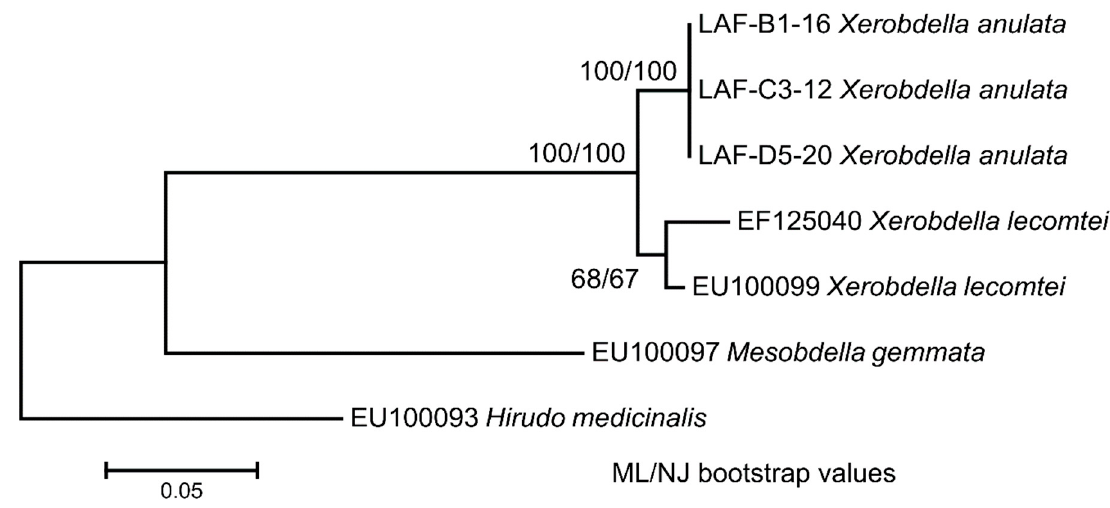
Figure 7. Molecular phylogenetic analysis using the maximum likelihood method. The ML tree is drawn to scale, with branch lengths measured in the number of substitutions per site. Bootstrap support of ML and Neighbor-Joining (NJ) trees are shown next to the branches.